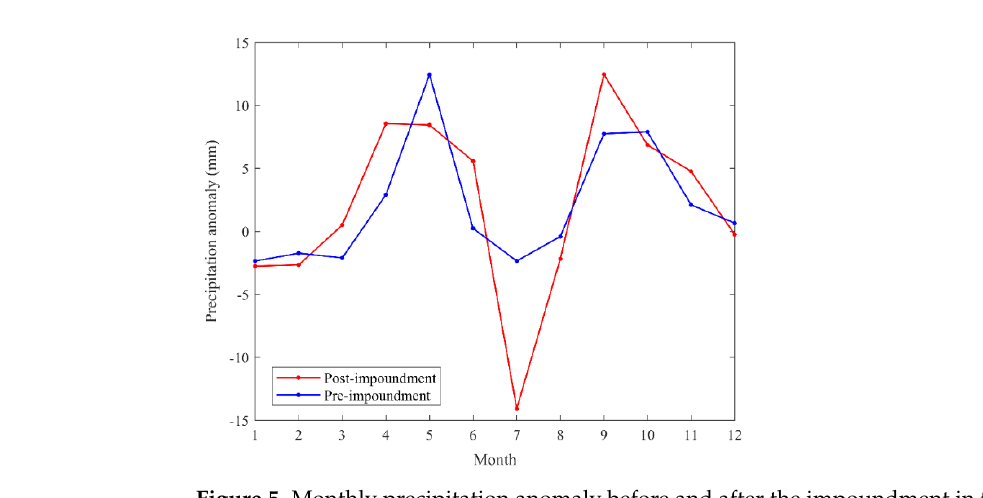
Figure 5. Monthly precipitation anomaly before and after the impoundment in the TGRA.